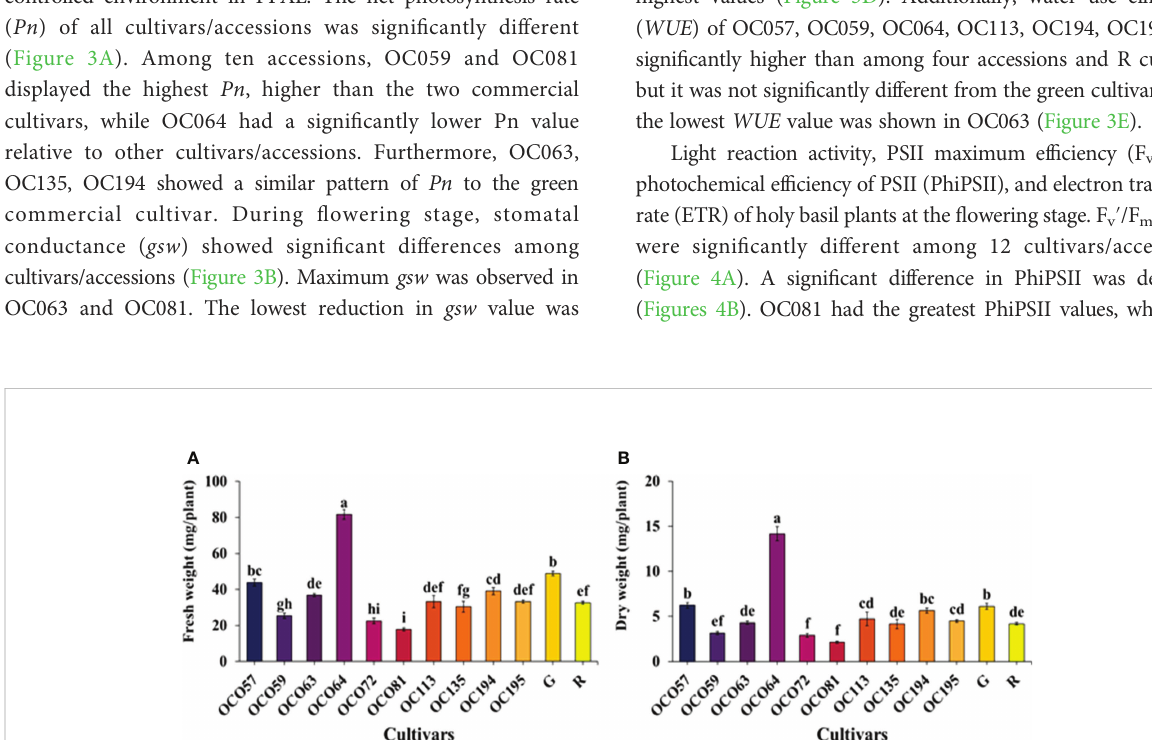
Values are represented as mean ± SE (n = 4). Different letters indicate signi fi cant differences between cultivations/accessions at p <